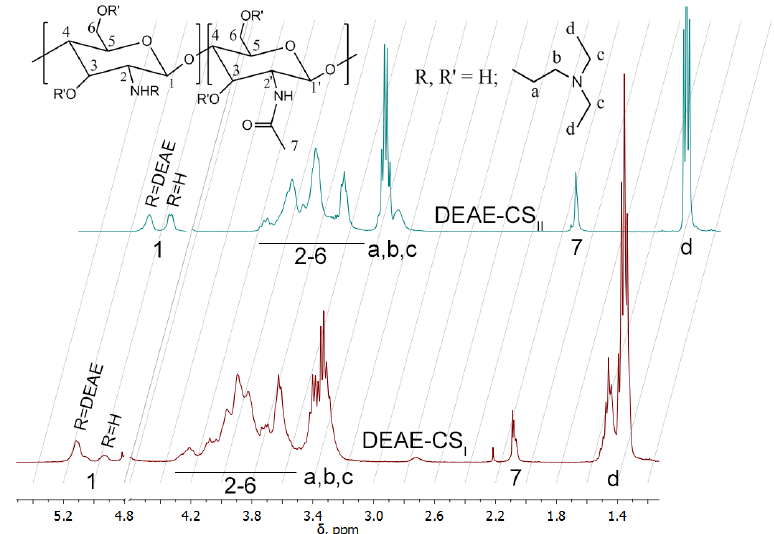
Figure 2. 1 H NMR spectra of diethylaminoethyl-chitosan (DEAE-CS I and DEAE-CS II with degrees of substitution of 1.2 and 0.57, respectively) (343 К, 400 MHz, D 2 O + CF 3 COOH).